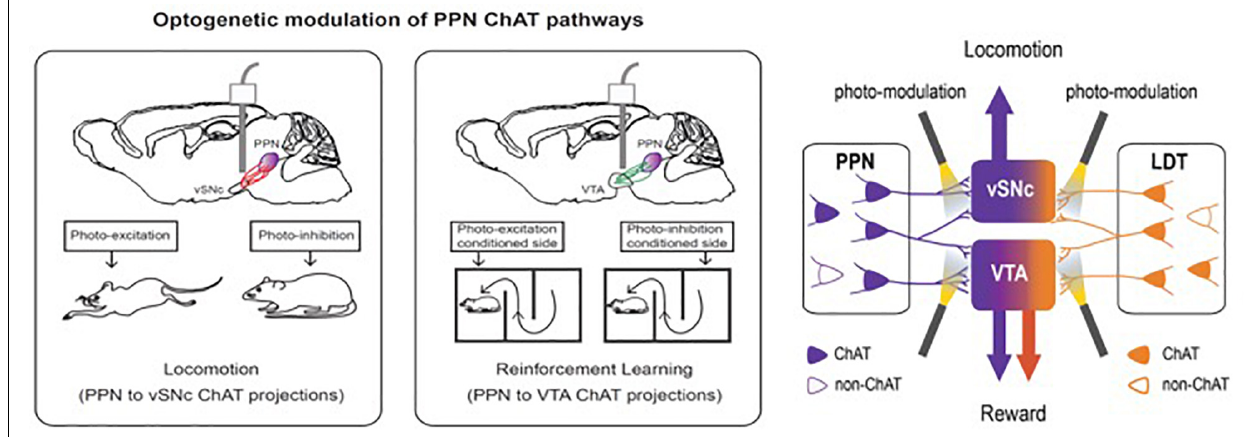
FIGURE 6 | Bidirectional manipulation of cholinergic cells in the PPN exert opposing effects on locomotor behavior and reinforcement learning via specific projections to the ventral substantia nigra pars compacta (vSNc) and the ventral tegmental area (VTA). This figure adapted from Cho et al.